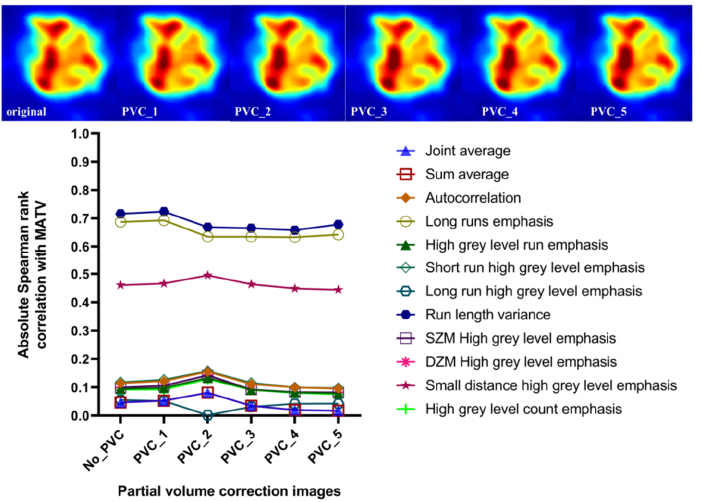
Figure 11. Correlation between features with excellent robustness and MATV from: original SUV and PVC images (with FWHM from 1 to 5) discretized with FBN = 128.